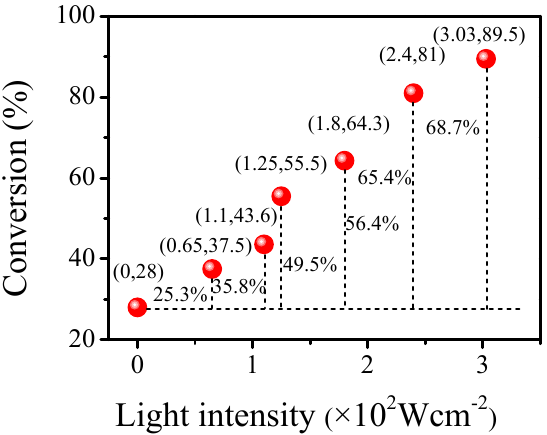
Figure 9. E ff ect of di ff erent light intensities on the reaction of benzyl alcohol and